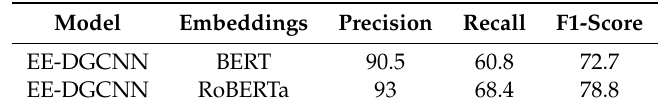
Table 2. Comparison of Bidirectional Encoder Representations from Transformers (BERT) and Robustly optimized BERT approach (RoBERTa).